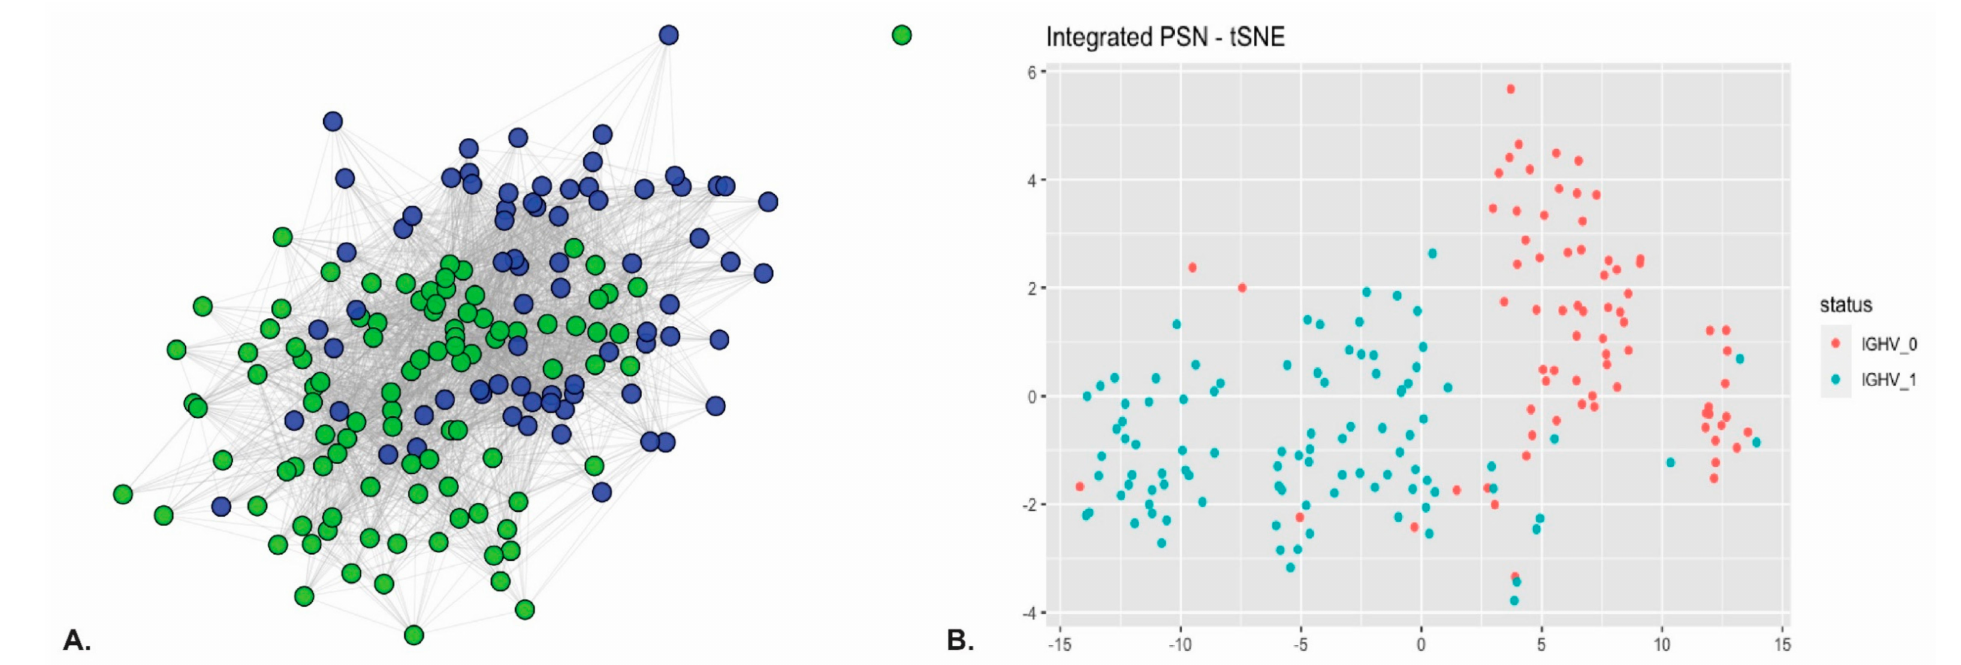
Figure 8. ( A ). Integrated patient similarity network for binary stratification of IGHV status based on multi-omic data (green—IGHV mutation, blue—no IGHV mutation). Each node in this network corresponds to a CLL patient and each edge corresponds to weights displaying the average similarity across all features passing feature selection [164]. This network was generated by implemented functions of netDx and visualized by Cytoscape. ( B ) tSNE visualization of integrated patient similarity network for binary stratification of IGHV status (IGHV_0 = no IGHV mutations, IGHV_1 = IGHV mutations). Only features which passed the feature selection step are